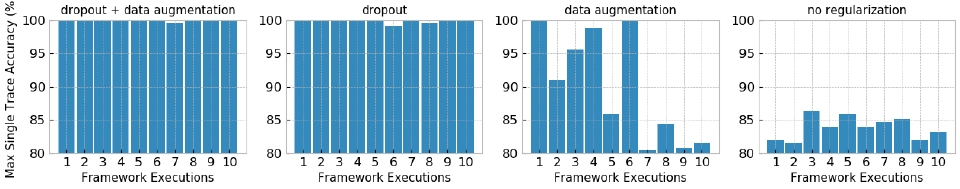
Figure 21: Fixed CNN hyperparameters: maximum single trace accuracy on the cswap- arith dataset for ten different framework executions and attacking the sample interval range from 1 500 to 3 500 of all sub-traces.